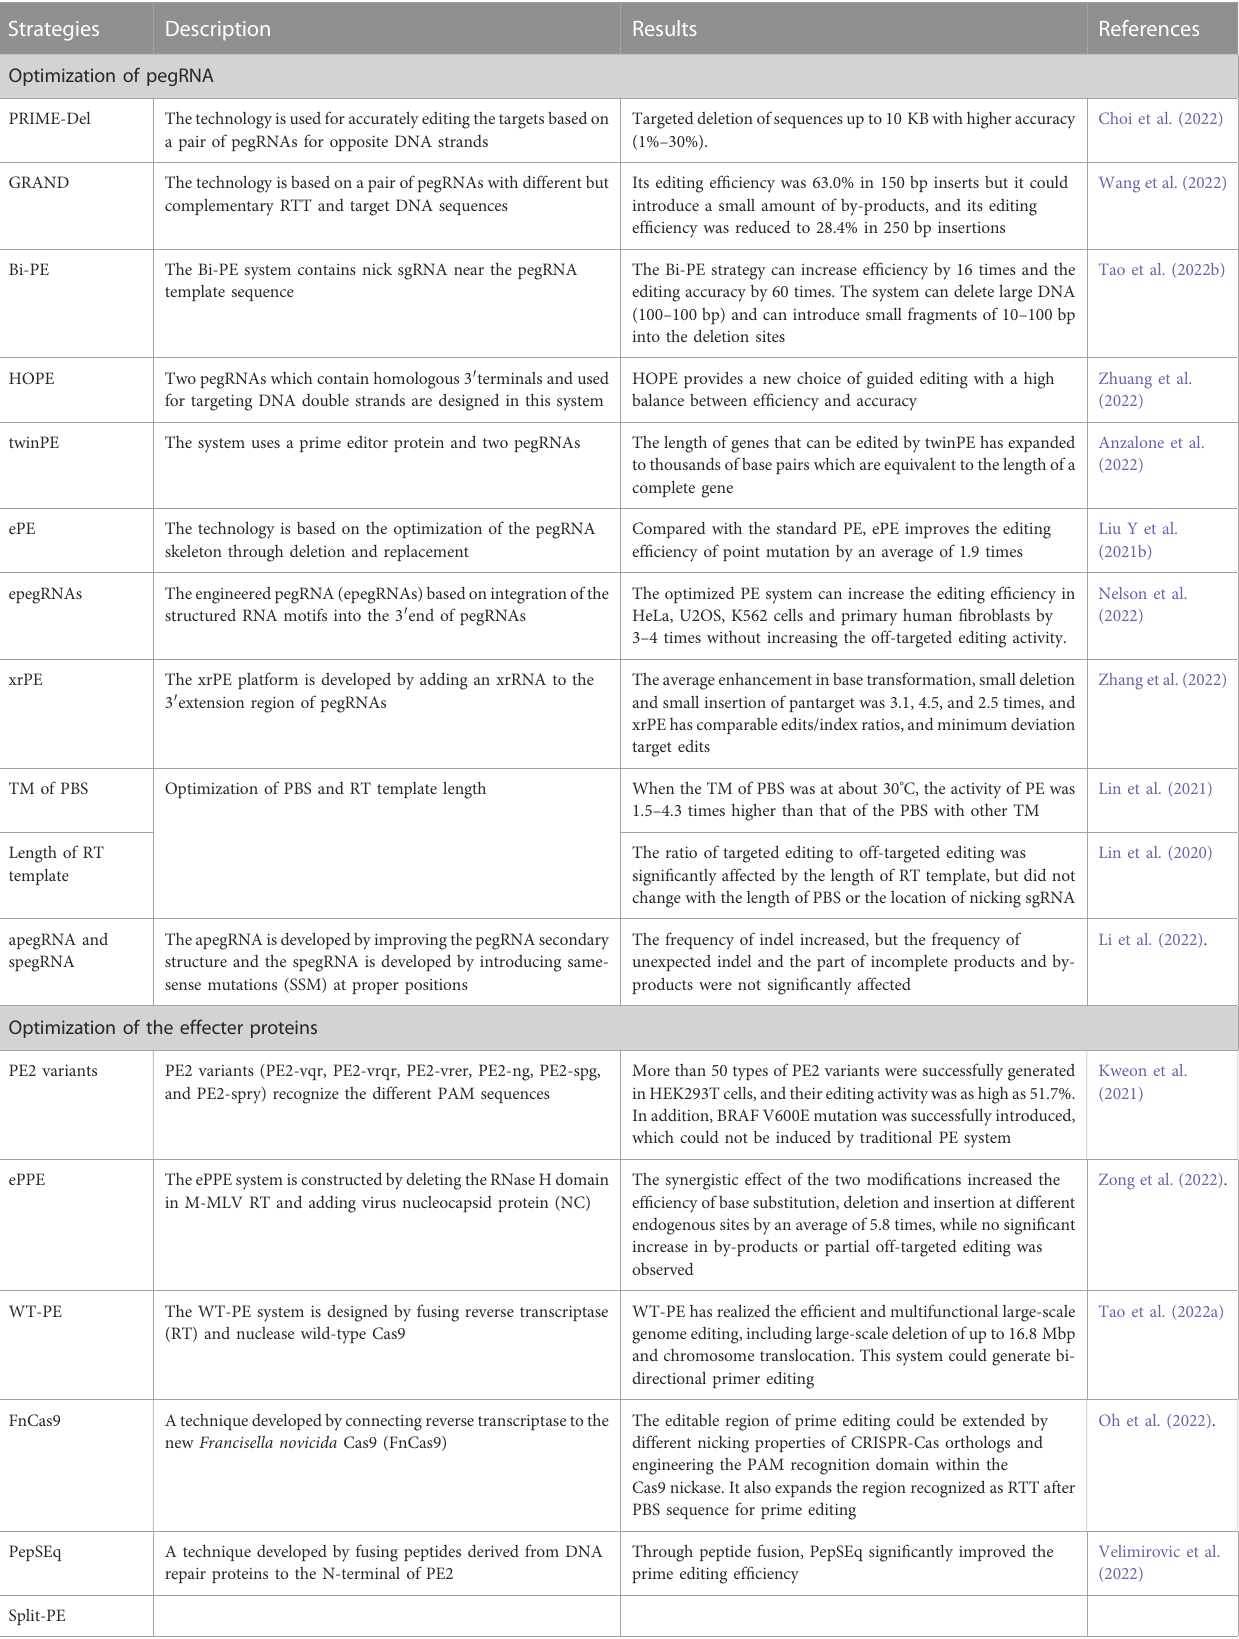
TABLE 2 Strategies used for optimization of the PE